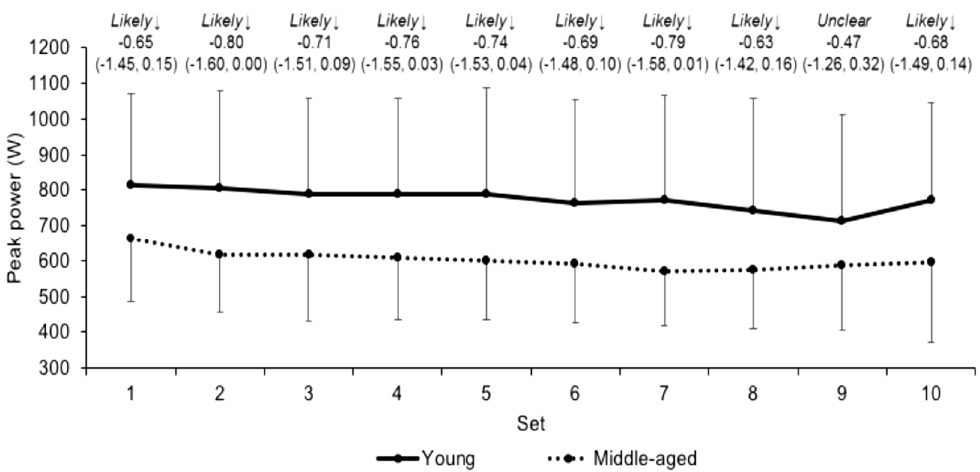
Figure 5. Peak power (mean ± SD) across each set in young and middle-aged groups. Qualitative descriptor, effect size, and upper and lower 90% confidence intervals are noted above. ↑ and ↓ denote higher and lower, respectively, in the middle-aged than young group.